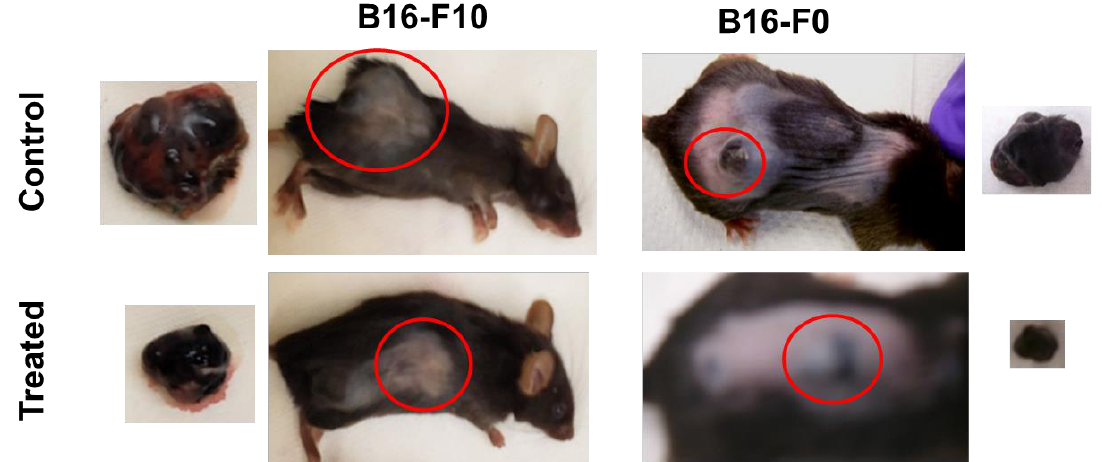
Appendix Figure A2. Photographs of the melanoma nodule of one representative mouse from each group are shown with red circle showing tumor. On day 15, the mice were euthanized. Excised tumors are presented with photographs at the same magnification of the excised tumor of another representative mouse from each group.